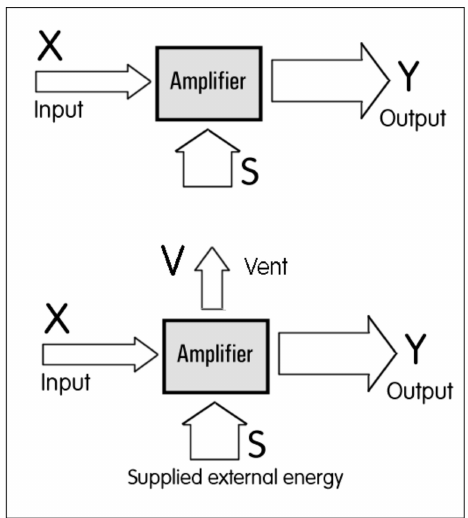
Figure 3. Schematic representation of a signal and power flows in a fluidic amplifier. Top: the simples amplifier with three terminals. Bottom: the diverter type amplifiers decrease the output flow rate by letting some fluid to flow away through the